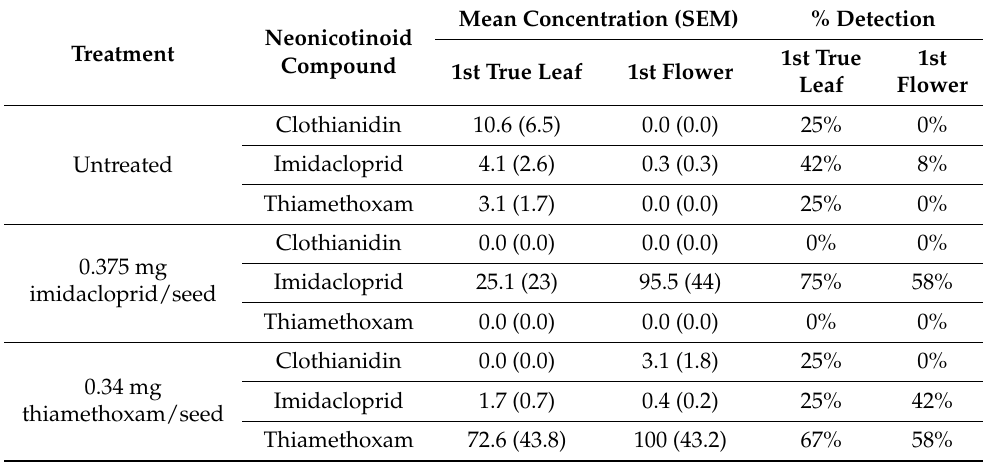
Table 5. Mean concentrations (ng/g) and percent detection of neonicotinoids detected in soil from cotton plots at the first true-leaf stage and when plants began to flower across all locations.